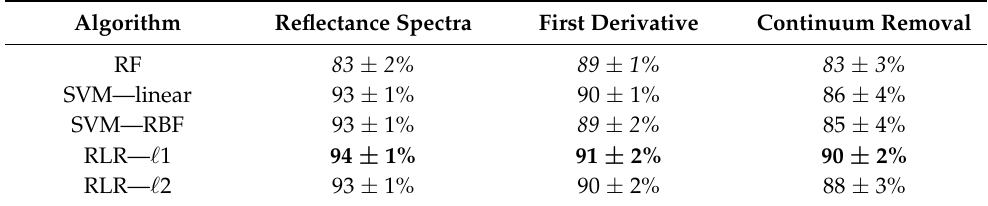
Table 6. Average Overall Accuracy (AOA) and standard deviation obtained from reflectance and transformations. The highest AOA is in bold and the lowest in italics.